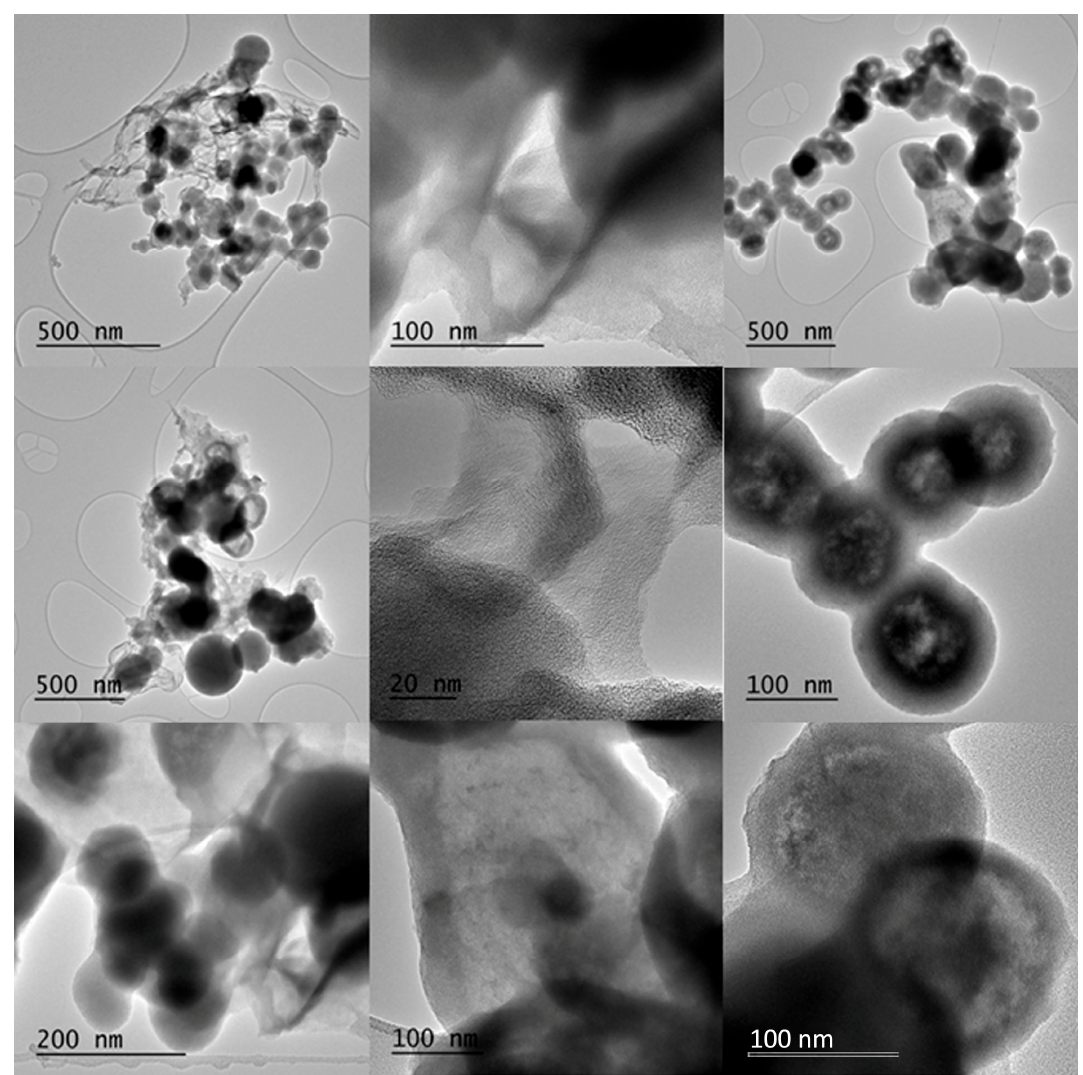
Figure 5. Representative TEM micrographs of carbon spheres ( left column ), nanosheets ( middle column ), and hollow spheres ( right column ).